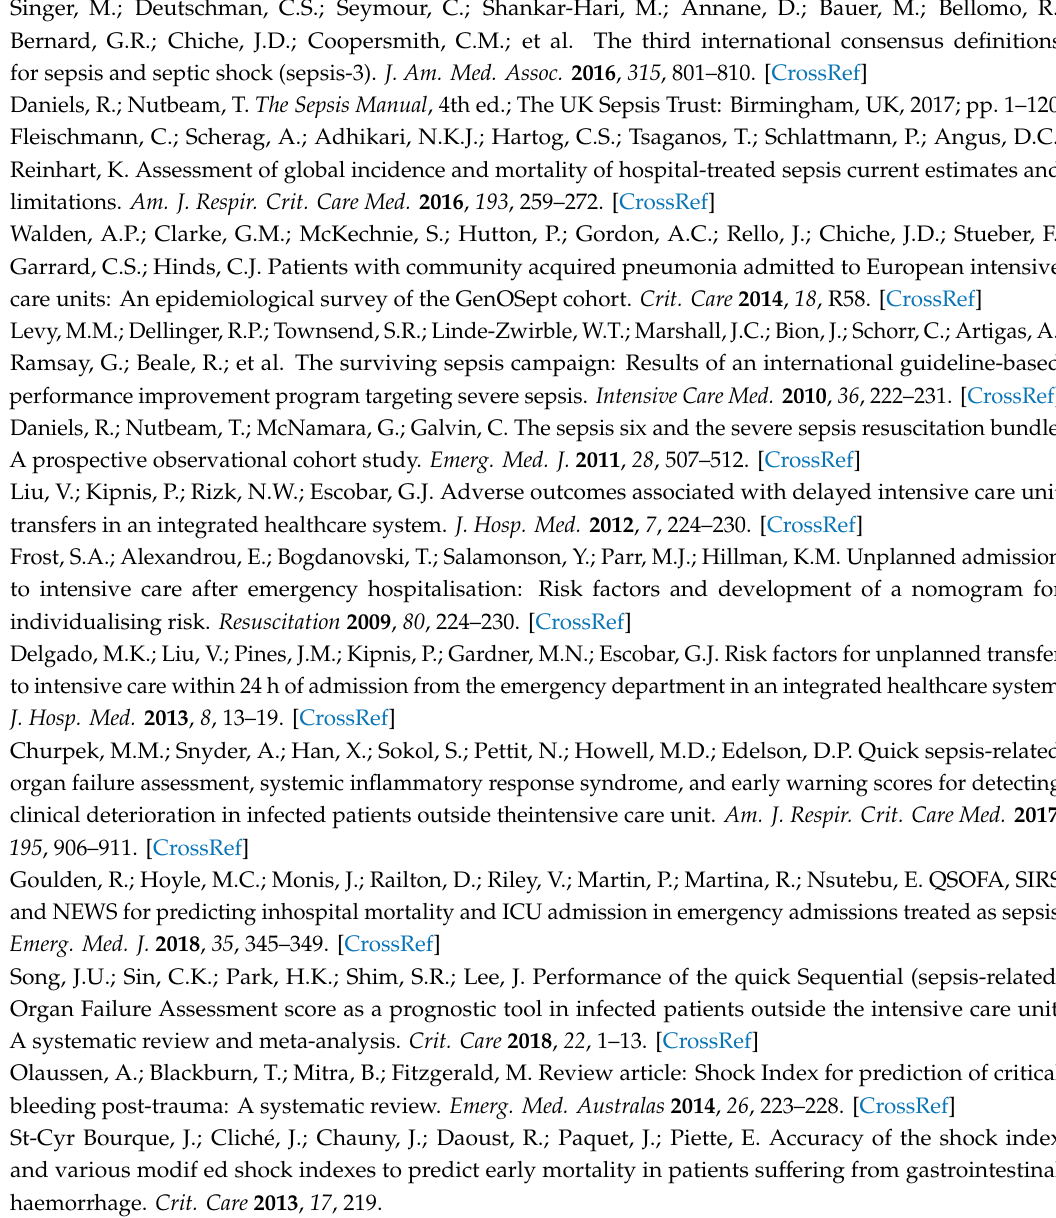
Table S1: Medline search strategy, Table S2: Downs and Black quality assessment for included studies, Table S3: CURASI score as a predictor of mortality in